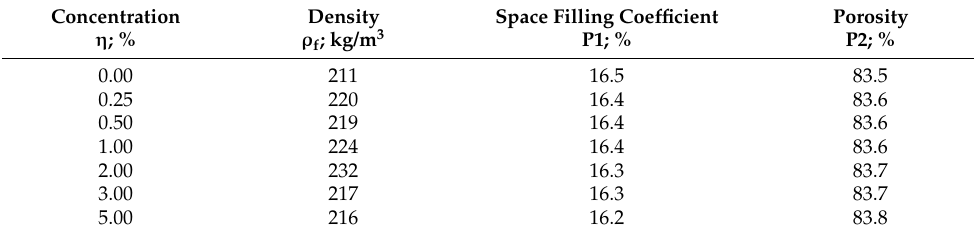
Table 5. Characteristics of light microscopy